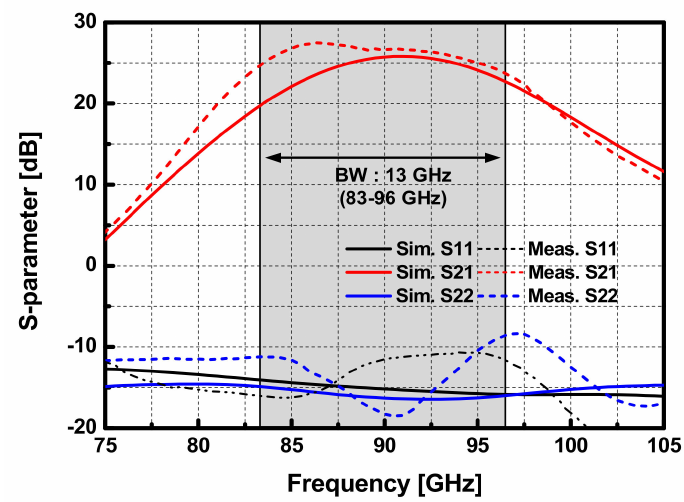
Figure 14. Measurement and simulation results of S-parameter of the W-band 8-way PA with a 50 Ω load.